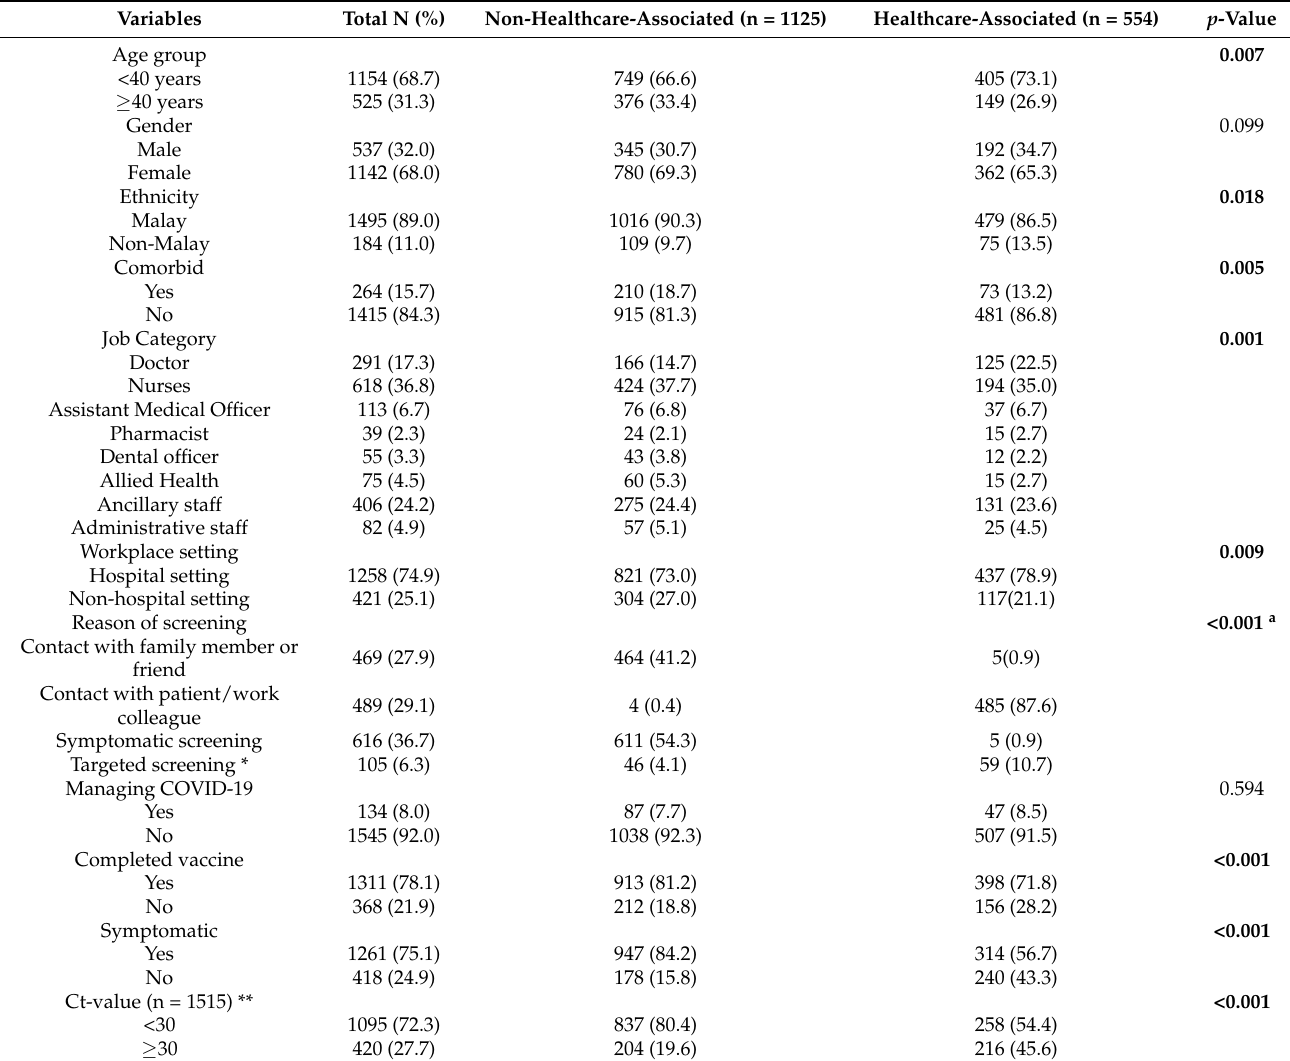
Table 1. Socio-demographic characteristics of study participants (N =